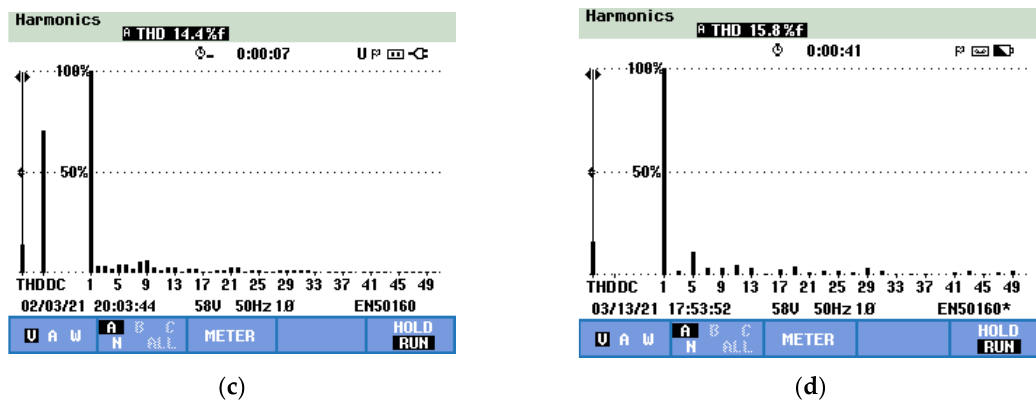
Figure 22. Harmonic spectra under ( a ) healthy condition ( b ) S 1 fault ( c ) S 3 fault ( d ) S 7 fault.